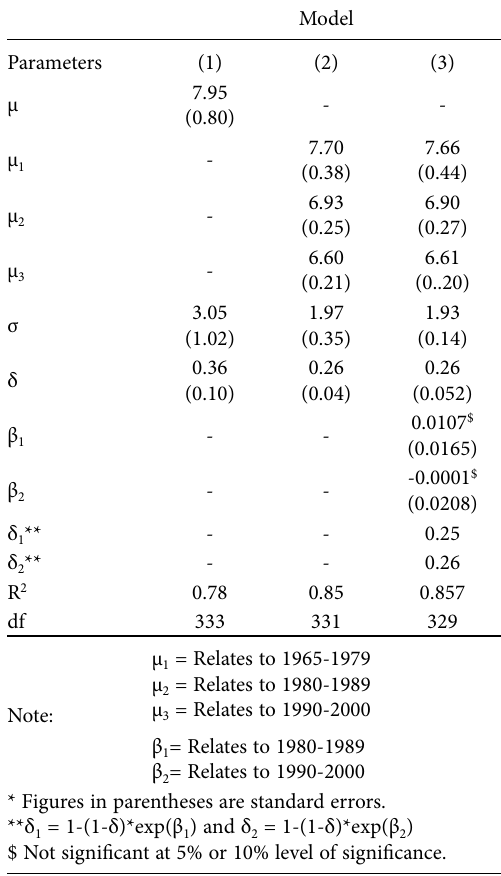
Table 5. Regression Results of Renewal Models for PVP Certificates-Agricultural